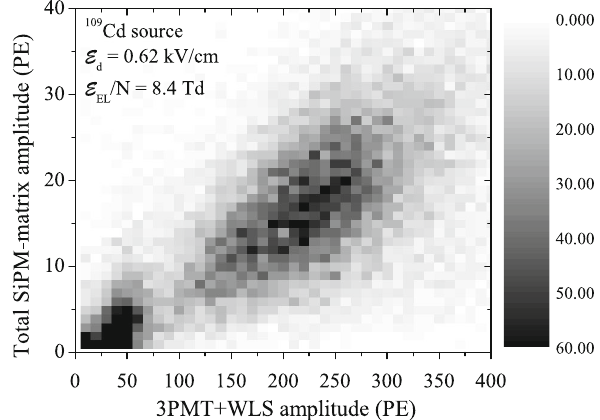
Fig. 9 Direct SiPM-matrix readout: amplitude spectrum of the total SiPM-matrix signal obtained with 109 Cd source. The hatched area cor- responds to the higher energy peak of the 3PMT + WLS signals (see Fig. 10)